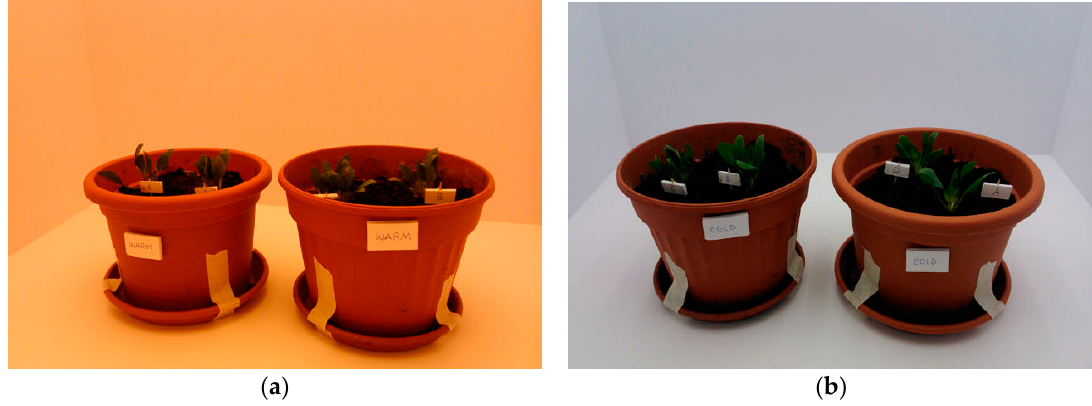
Figure 1. Pictures of the two growth conditions: warm white lighting ( a ); and cold white lighting ( b ). The artificial lighting was provided with non-dimmed LED devices measuring 60 cm × 60 cm and containing four luminous strips shaded by a diffusive glass: this typology of luminaries has been selected for their small form factor, which allows to get the required uniformity of flux distribution and to reduce shadows. The cold source has 30 LEDs embedded in the luminous strips while in the warm one 42 LEDs are included. The lamps are powered with 230 V. Lighting efficiency of the sources is shown in Table 1. Both the efficiency for human light perception (lumen/watt) and plant growth (micromoles of photosynthetic photons per joule of energy input) are shown. Nelson and Bugbee [32] highlighted that luminous efficiency (lm/W) is a unit linked to the visual system